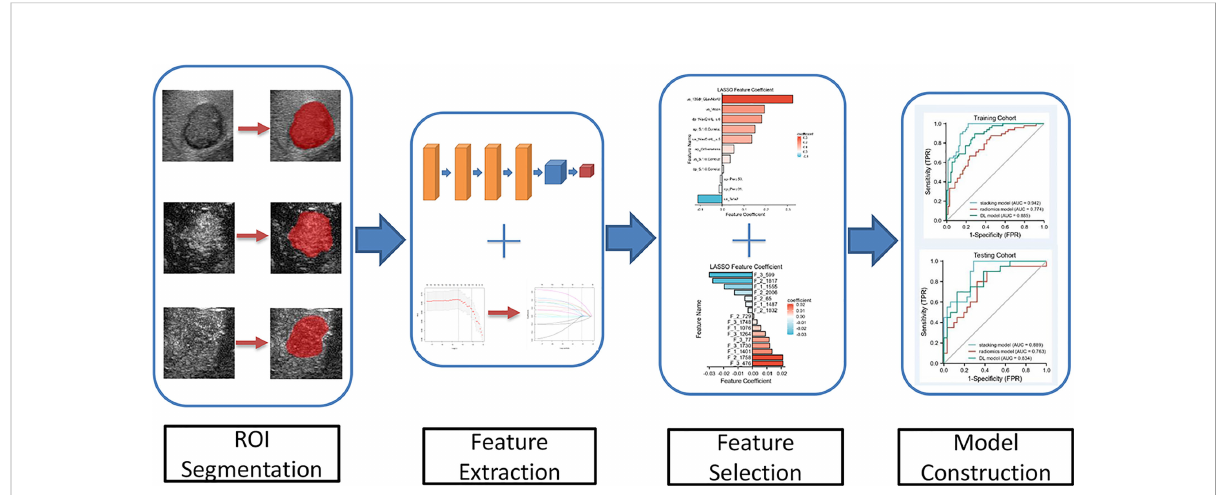
FIGURE 2 The fl ow chart of CEUS-based deep learning radiomics analysis for predicting ER of HCC is